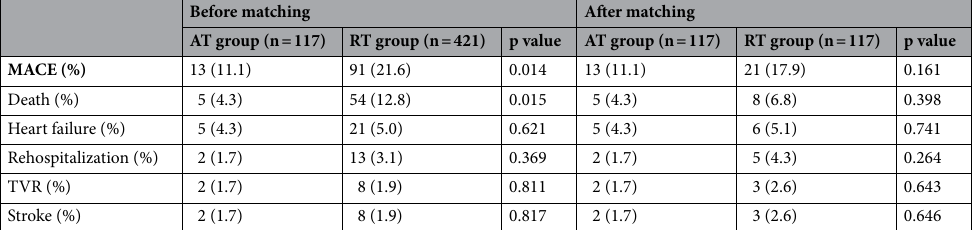
Before matching After